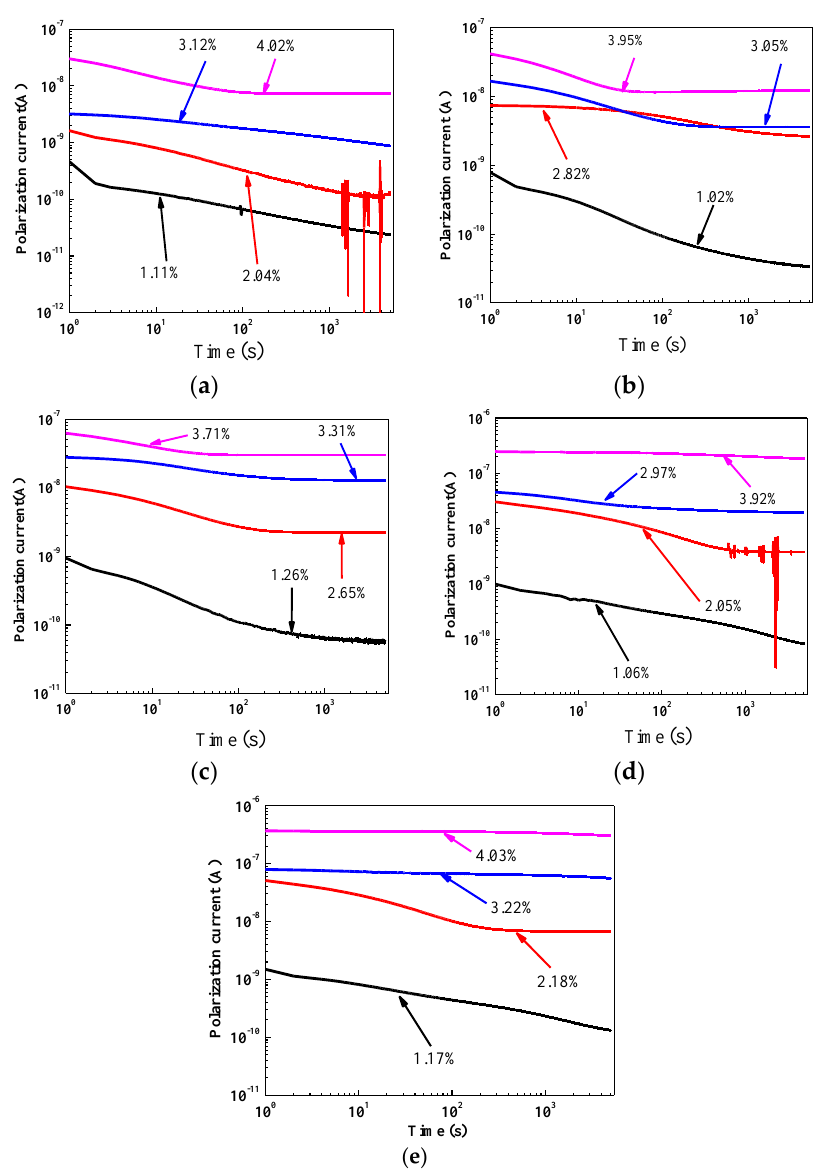
Figure 9. Polarization current results of oil-impregnated pressboards with different water contents. ( a ) Ageing for 0 day; ( b ) Ageing for 8 days; ( c ) Ageing for 21 days; ( d ) Ageing for 32 days; ( e ) Ageing for 42 days.